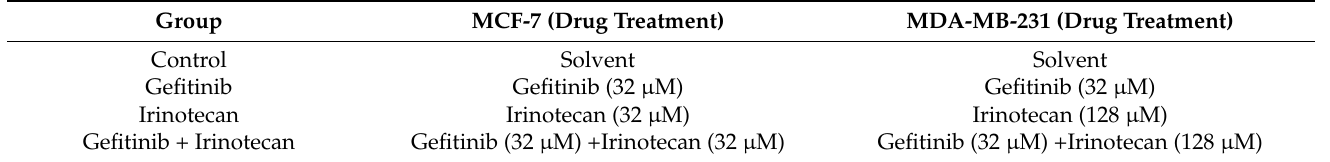
Table 1. Group information of wound healing analysis.